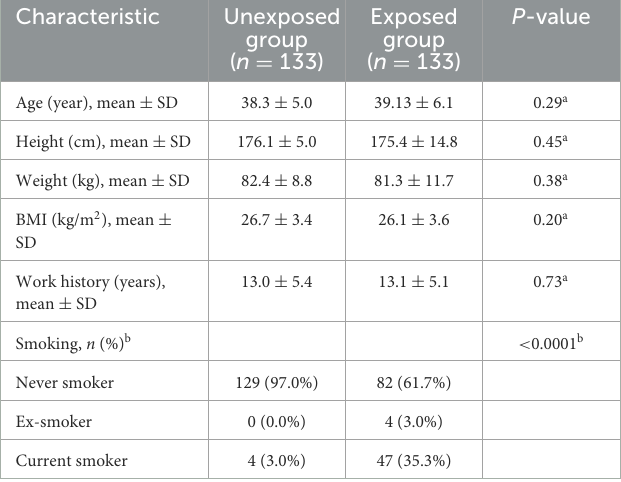
TABLE 1 Characteristics of the study population including 133 steel factory workers and 133 office